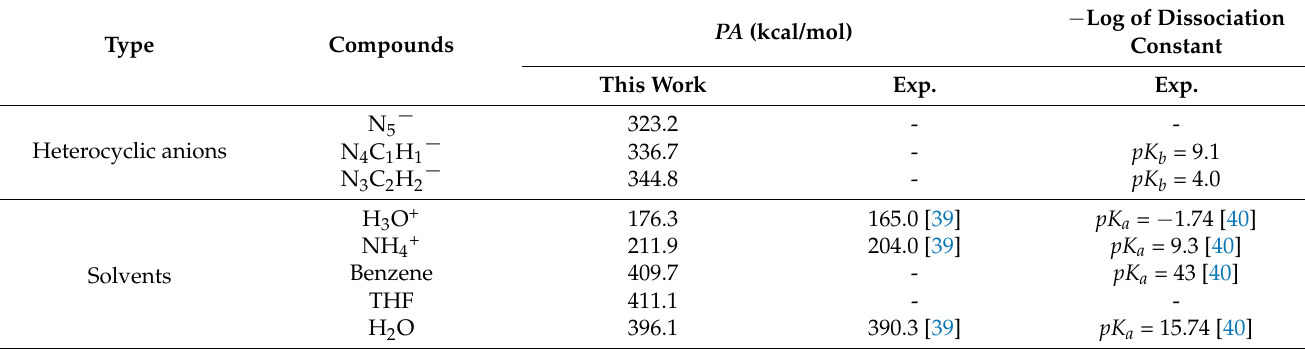
Table 2. Basicity of heterocyclic anions and acidity of solvents